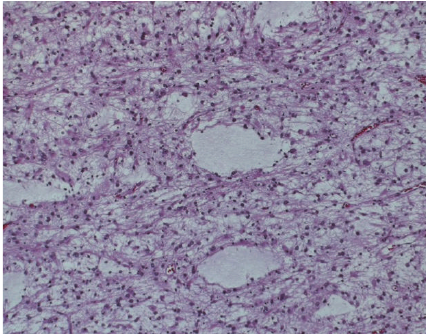
Figure 4: Microphotograph shows anaplastic astrocytoma with numerous mitoses (Hematoxylin & Eosin, original magnification × 20).